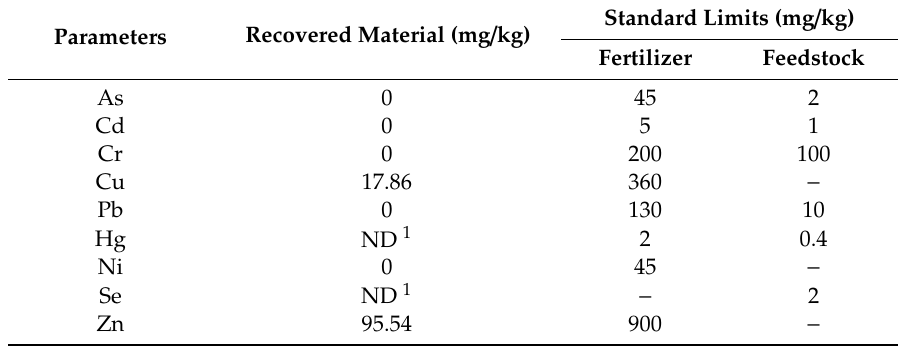
Table 3. Concentration of selected heavy metals in the recovered material and the threshold limits of heavy metals in fertilizer and feedstock suggested by the Korean Regulatory